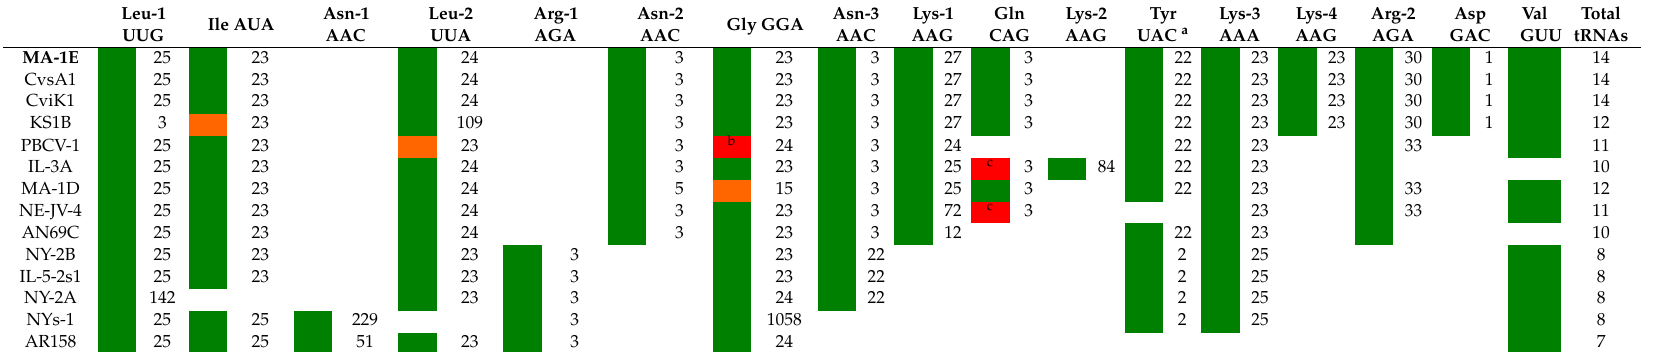
Table 1. The order of clustered tRNA genes in NC64A chloroviruses 1 .